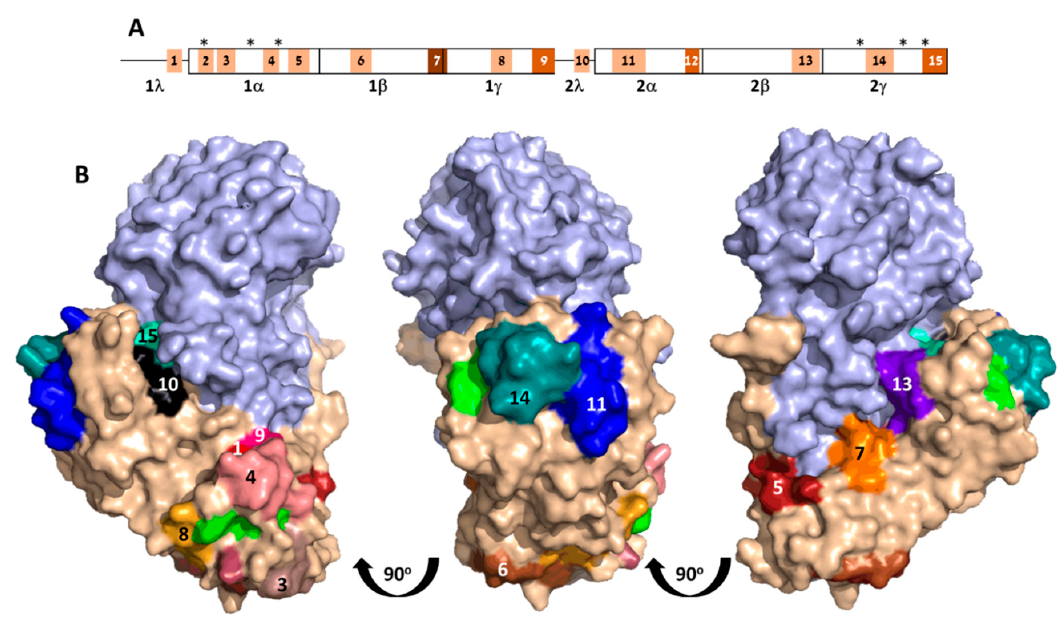
Figure 4. Immunodominant epitopes on ATB. ( A ) Linear depiction of two ATB subunit homologous globular domains and amino acid residues comprising galactose-binding pockets of each domain (marked by asterisks). Location of immunodominant epitopes (1–15) marked as shaded boxes, whereas shading tones represent number of sera that reacted with each epitope (pale to darkest for 1 to 4 sera, respectively). ( B ) Crystal structure of abrin (PDB 1abr; ATA in pale blue and ATB in light brown). Immunodominant epitopes color-coded and numbered; galactose-binding pockets in green.